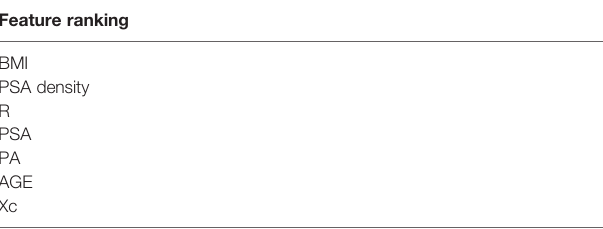
TABLE 6 | Feature ranking according to the RFE criterion.